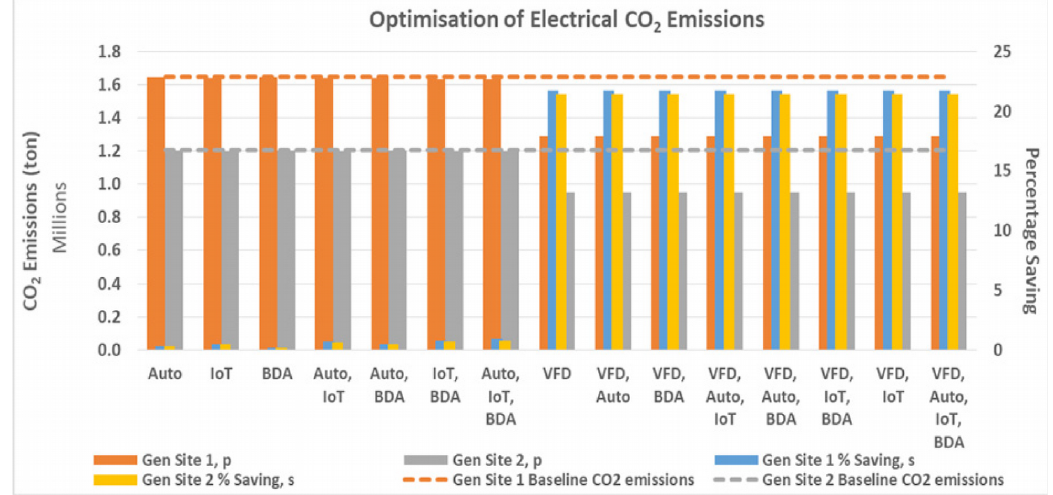
Figure 11. Impact of optimization technologies on CO